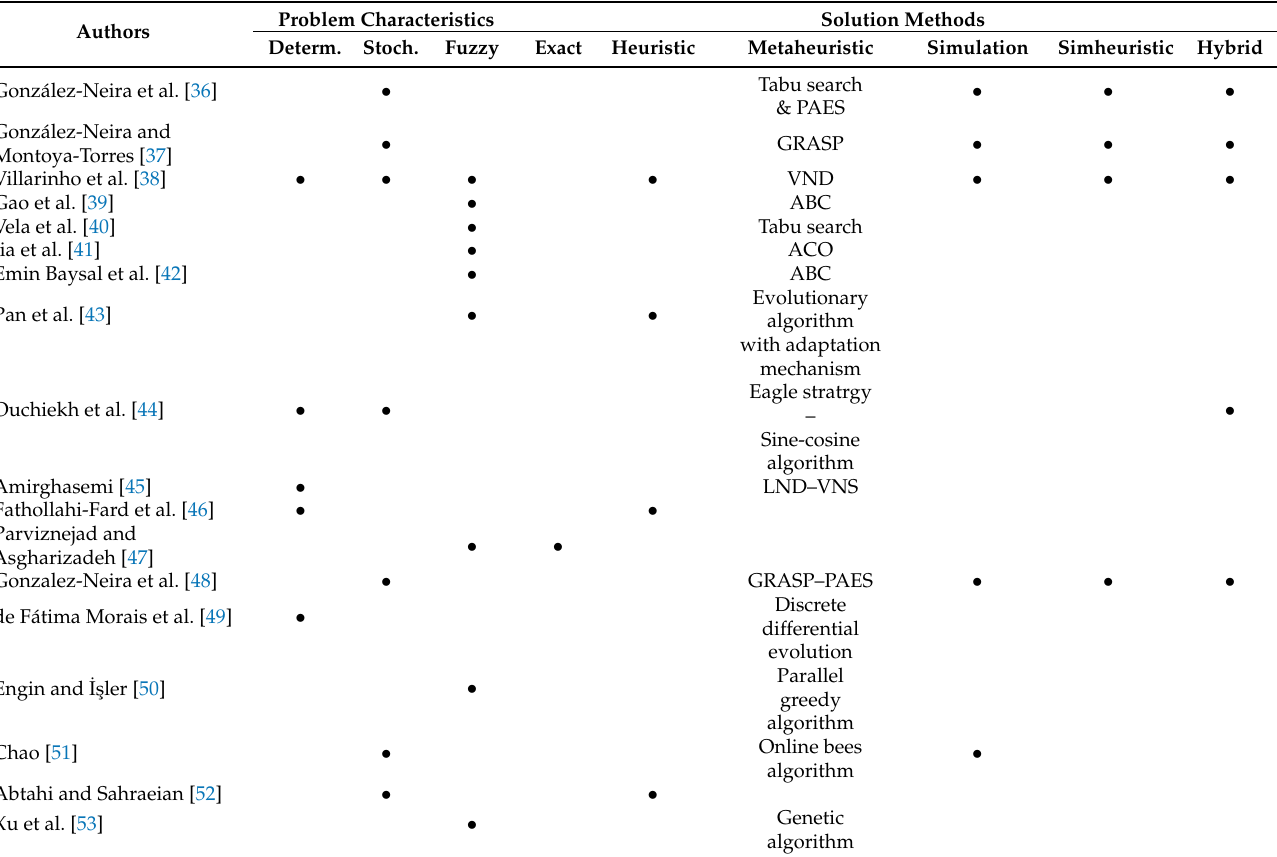
Table 1. Recent work on the PFSP with uncertainty available in the literature.